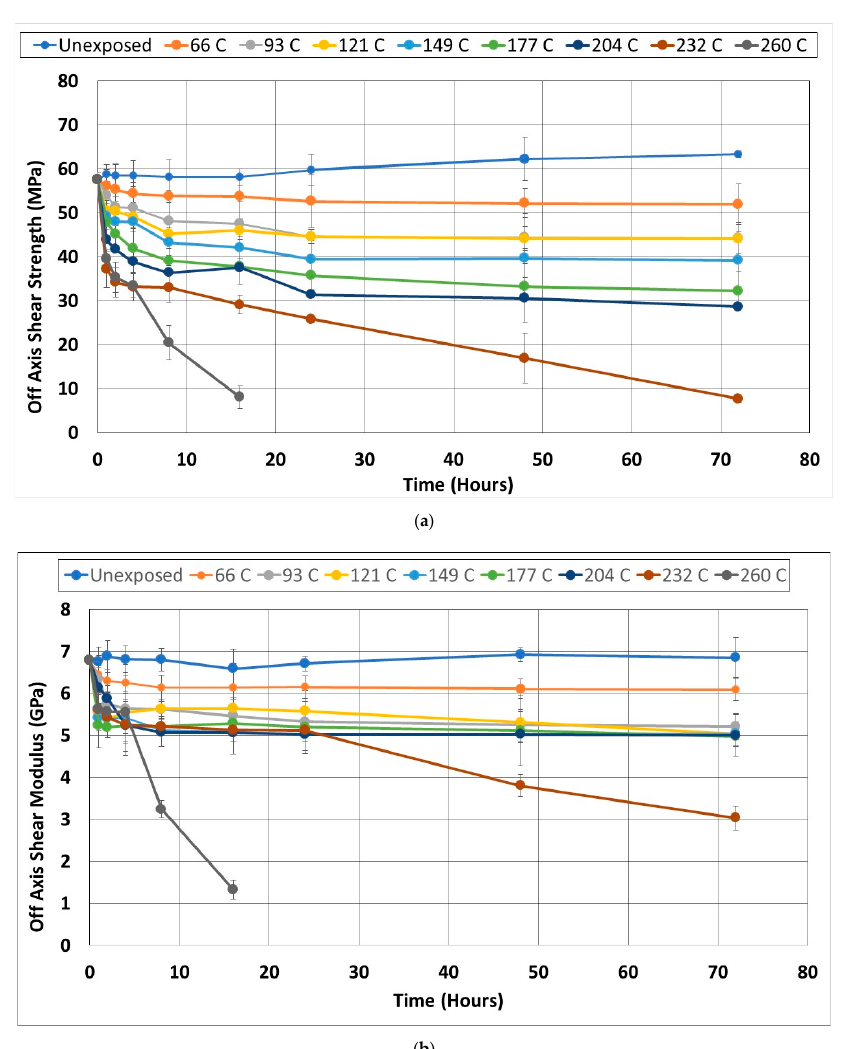
Figure 4. ( a ) Change in Off-Axis Shear Strength as a function of exposure temperature and time; ( b ) Change in Off-Axis Shear Modulus as a function of exposure temperature and time.